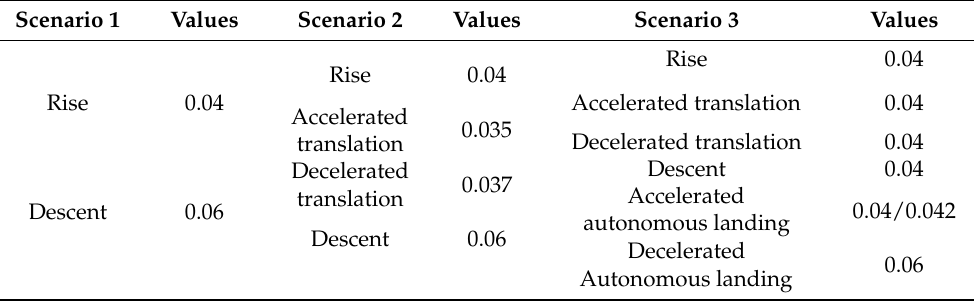
Table 4. Weighted coefficients for different